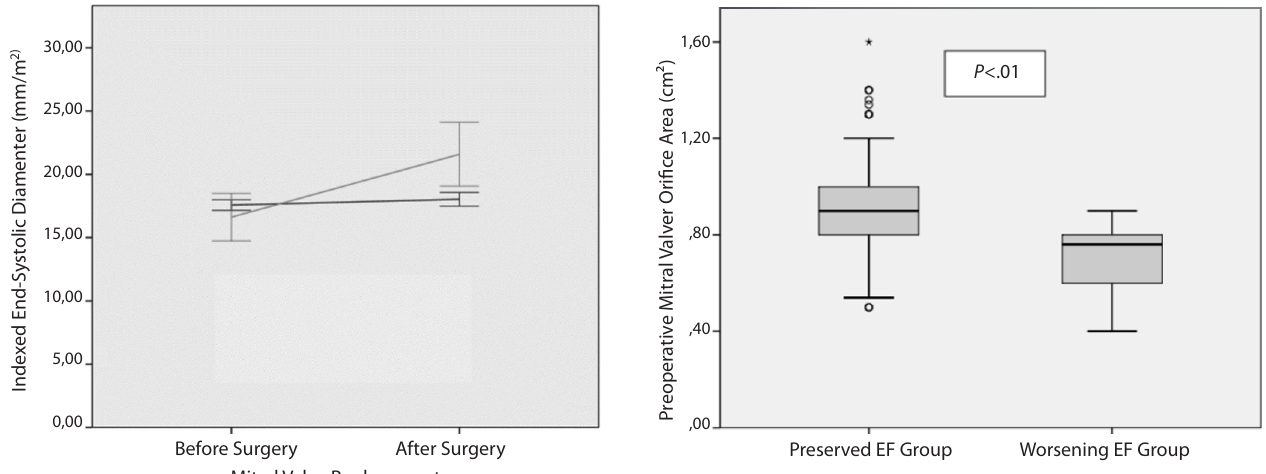
Fig. 1 - Indexed left ventricular end-systolic diameter pattern of remodeling after mitral valve replacement according to the study group (dark line=preserved ejection fraction [EF] group; light line=worsening EF group).